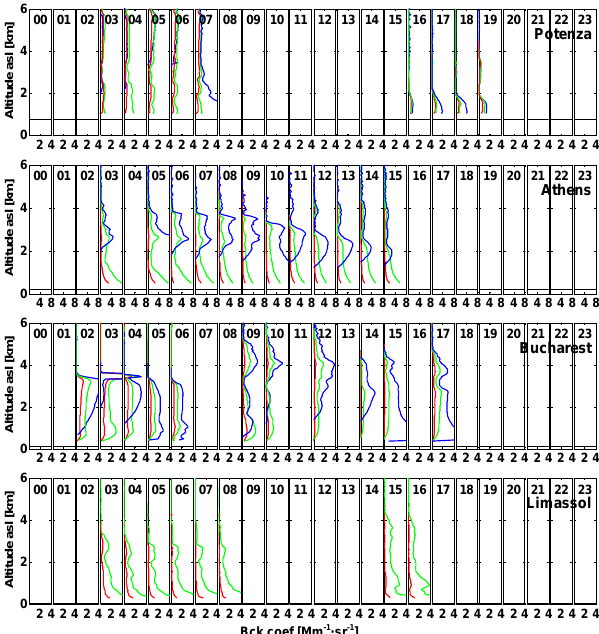
Figure 7. Time series of elastic-inverted backscatter coefficient pro- files (SCC-2 product) on J10 at 355 (blue), 532nm (green) and 1064nm (red) at the Iberian stations ordered west to east. The num- bers below the top axis indicate the time in UT. The horizontal black lines represent the station’s altitude asl.